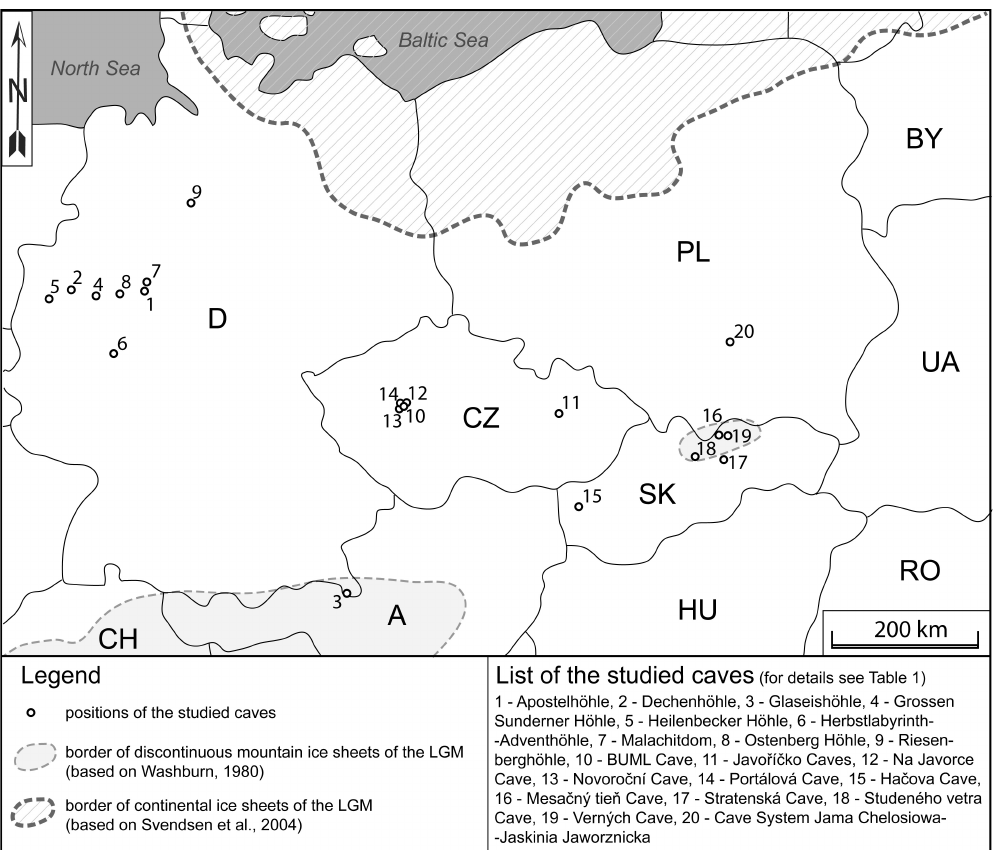
Fig. 2. Locations of the studied caves in Central Europe. The limits of continental and Alpine mountain glaciation during the Last Glacial are taken from Washburn (1980) and Svendsen et al.